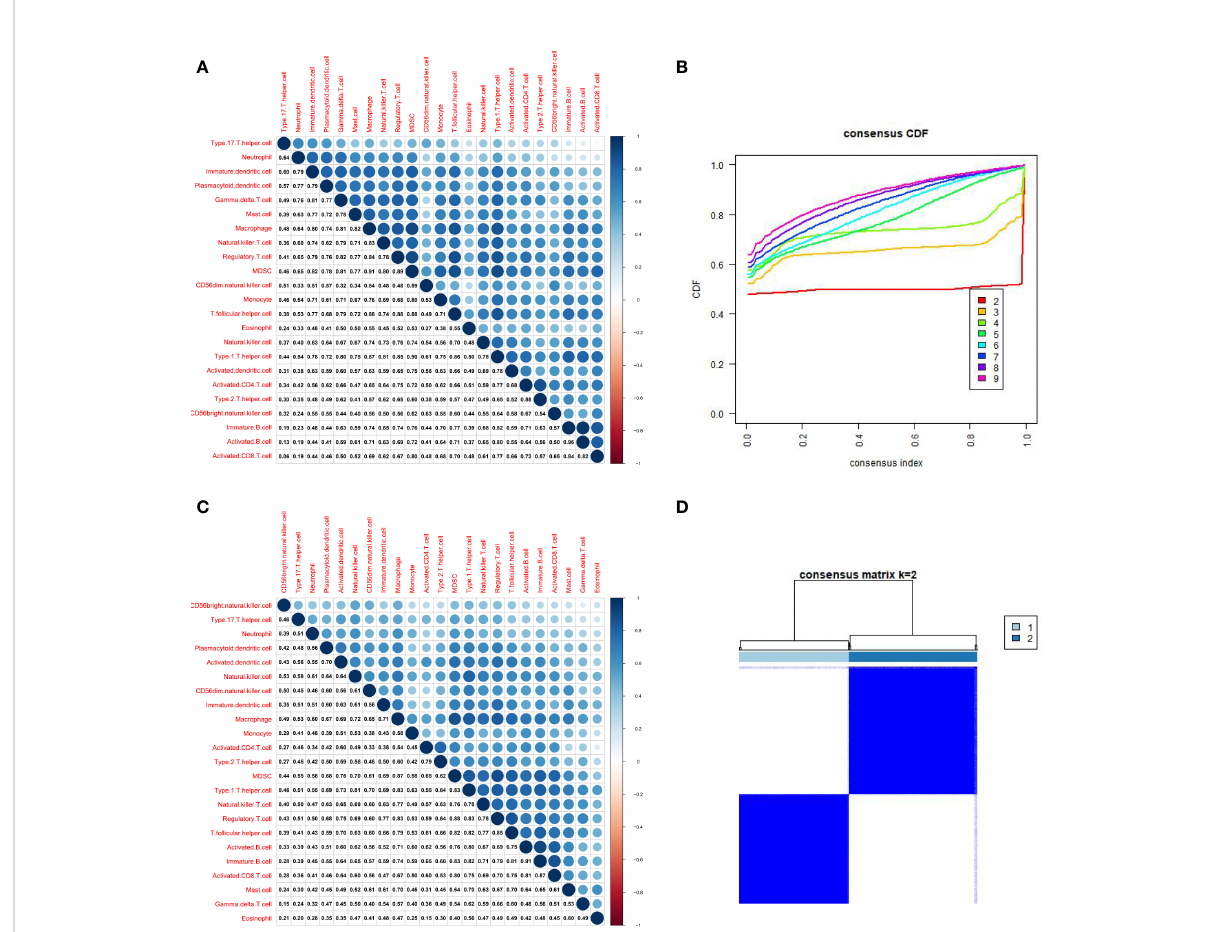
FIGURE 3 Differentialized immune cell in fi ltration patterns are present in HCC samples. (A) . Correlation analysis of 23 kinds of immune cells based on ssGSEA algorithm shows the correlation of in fi ltration ratio of each immune cell in paracancerous tissue (The size of the circle represents the size of the correlation). (B) . Correlation analysis of 23 kinds of immune cells based on ssGSEA algorithm shows the correlation of in fi ltration ratio of each immune cell in HCC tissue (The size of the circle represents the size of the correlation). (C) . CDF results showed different immune in fi ltration patterns in HCC samples, according to unsupervised clustering of HCC samples (D) . The heat map shows that HCC patients can be divided into 2 subtypes (subtype A and subtype